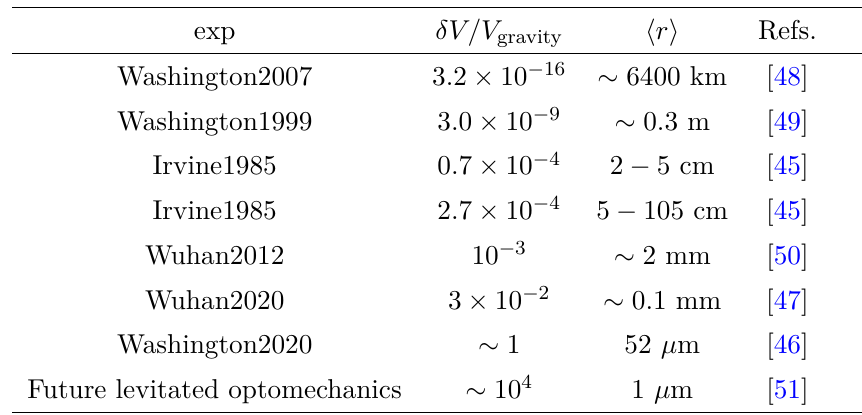
Table 4 . Sensitivities of long-range force search